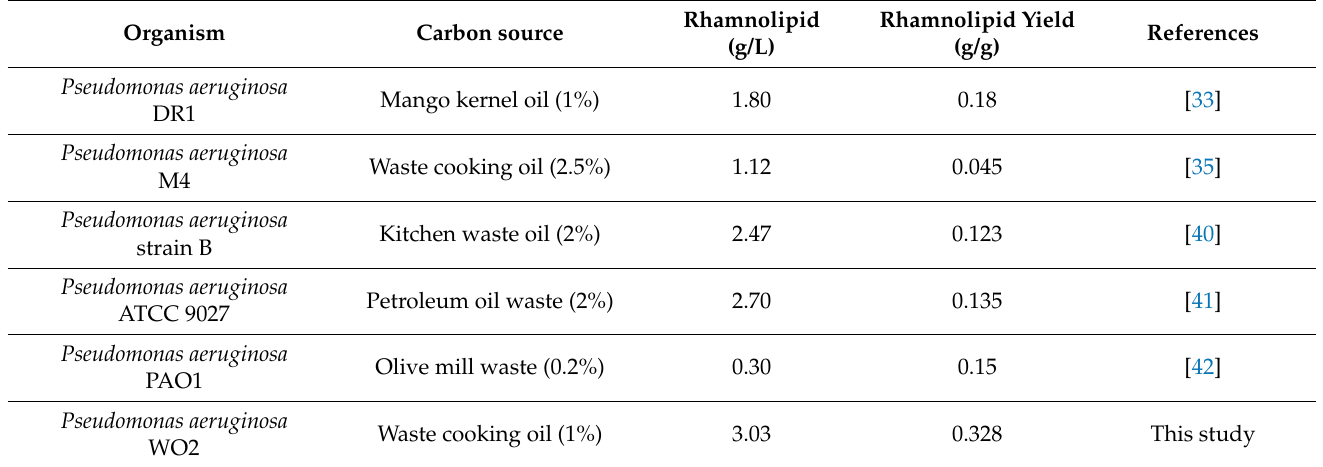
Table 2. Performance of different organism during waste oil-based rhamnolipid fermentation.